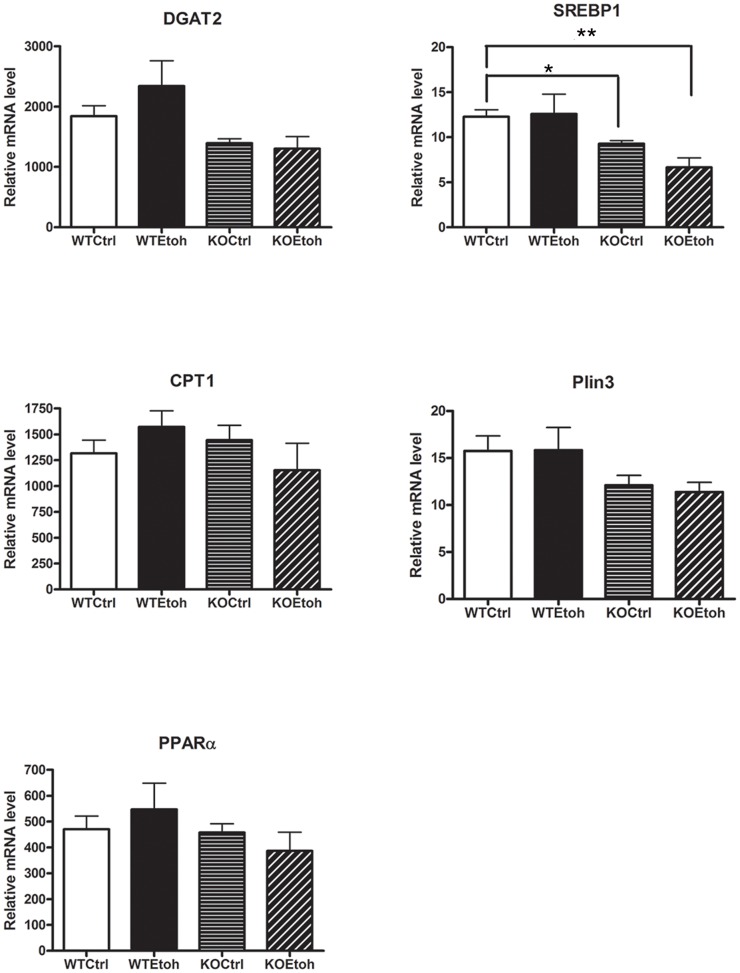
Liver mRNA of wildtype and Plin2KO mice fed control or ethanol diets.Hepatic mRNA expression relative to 36B4 (phosphoriboprotein) using liver lysates of wildtype (WT) and Plin2KO (KO) mice fed six weeks of control (Ctrl) or ethanol (Etoh) diets. N = 5 mice/group. DGAT2 =  diacylglycerol O-acyltransferase 2; CPT1 =  Carnitine palmitoyltransferase I; PPARα =  peroxisome proliferator-activated receptor alpha; SREBP1 = Sterol regulatory element-binding protein 1; Plin3 =  Perilipin 3. Data reported are means ±SEM. *p = 0.02 **p = 0.003. p<0.05 is considered significant.